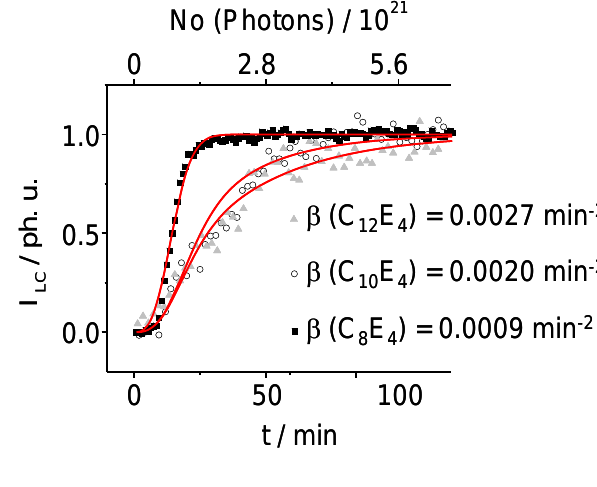
Figure 10. Overlay of the transformation–profile showing the time- dependence of the integral intensity scatter of the LC reflection. The curves are fitted according to the homogeneous dispersive kinetics theory (Equation 8) allowing extracting parameters to determine the transition-entropy (Equation 9). On the basis of this theory, the conversion depends on the value of the time-dependent rate